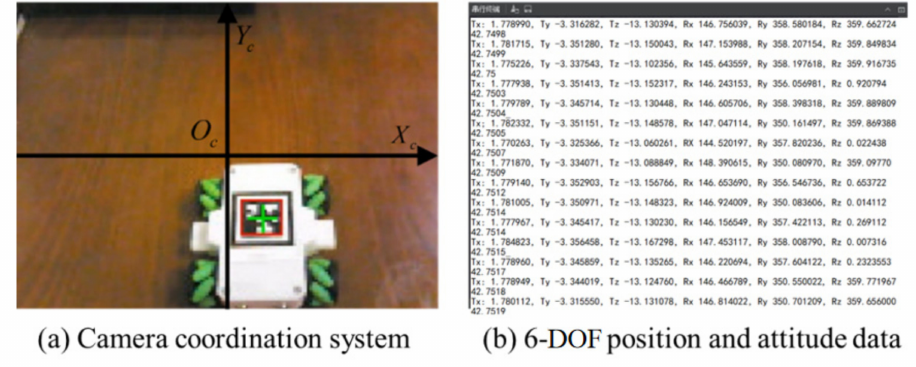
Figure 14. 6-DOF position and attitude information output of a modular